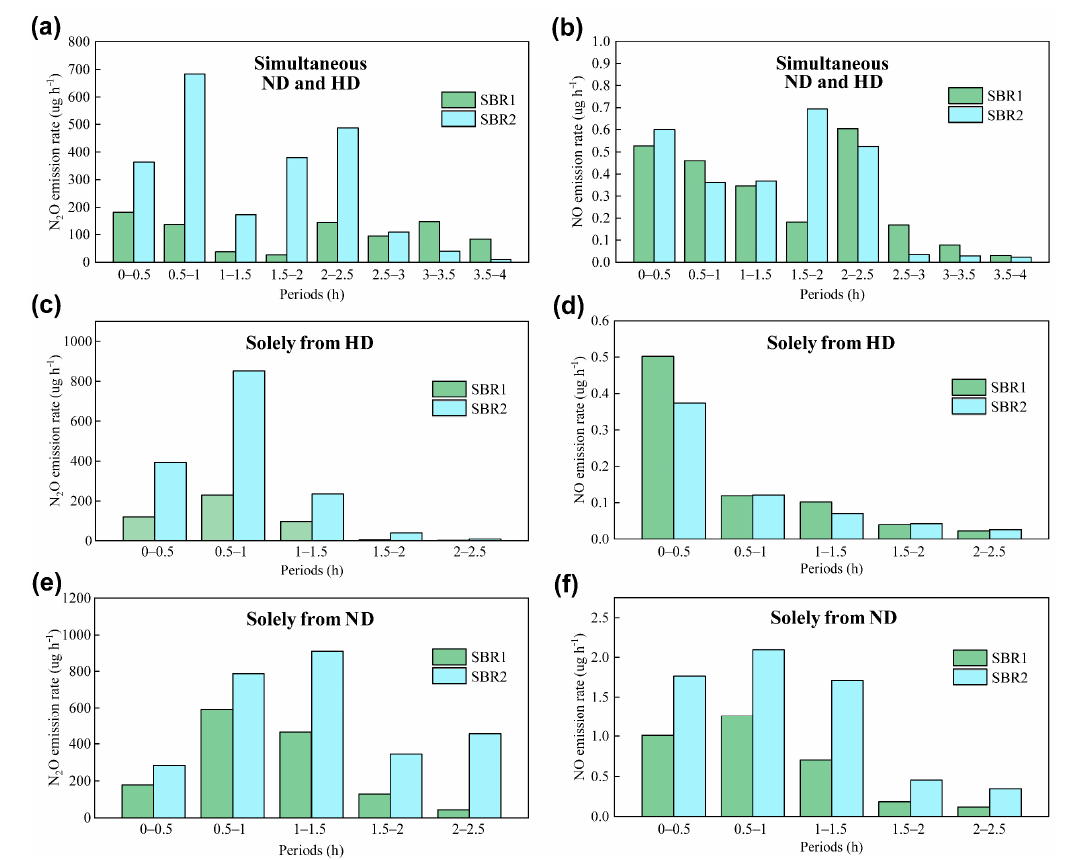
Figure 3. N 2 O and NO emission rates during each 30-min period of different biological processes in batch experiments: ( a , b ) from both ND and HD processes; ( c , d ) solely from the HD process; ( e , f ) solely from the ND process. Table 2. N 2 O and NO emission rates and factors of different biological processes in batch experiments.